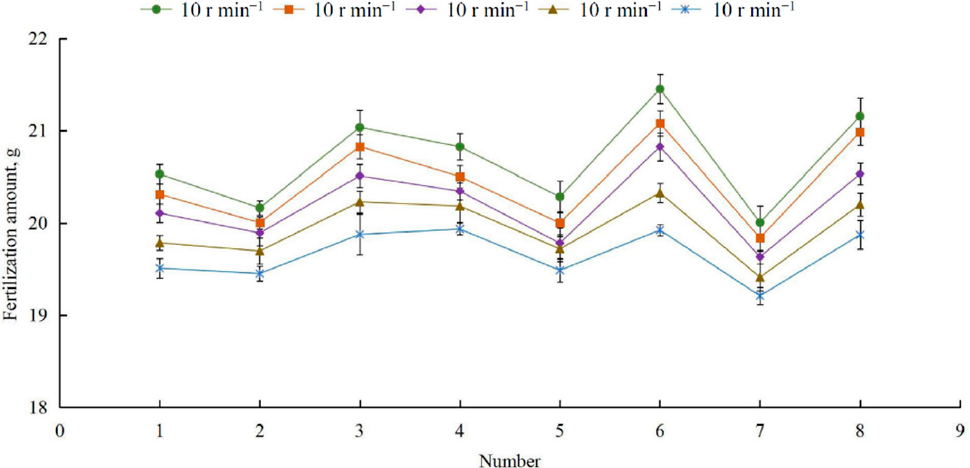
Figure 7. Amount of fertilizer applied during a single turn of the fertilizer distribution apparatus at different working speeds.